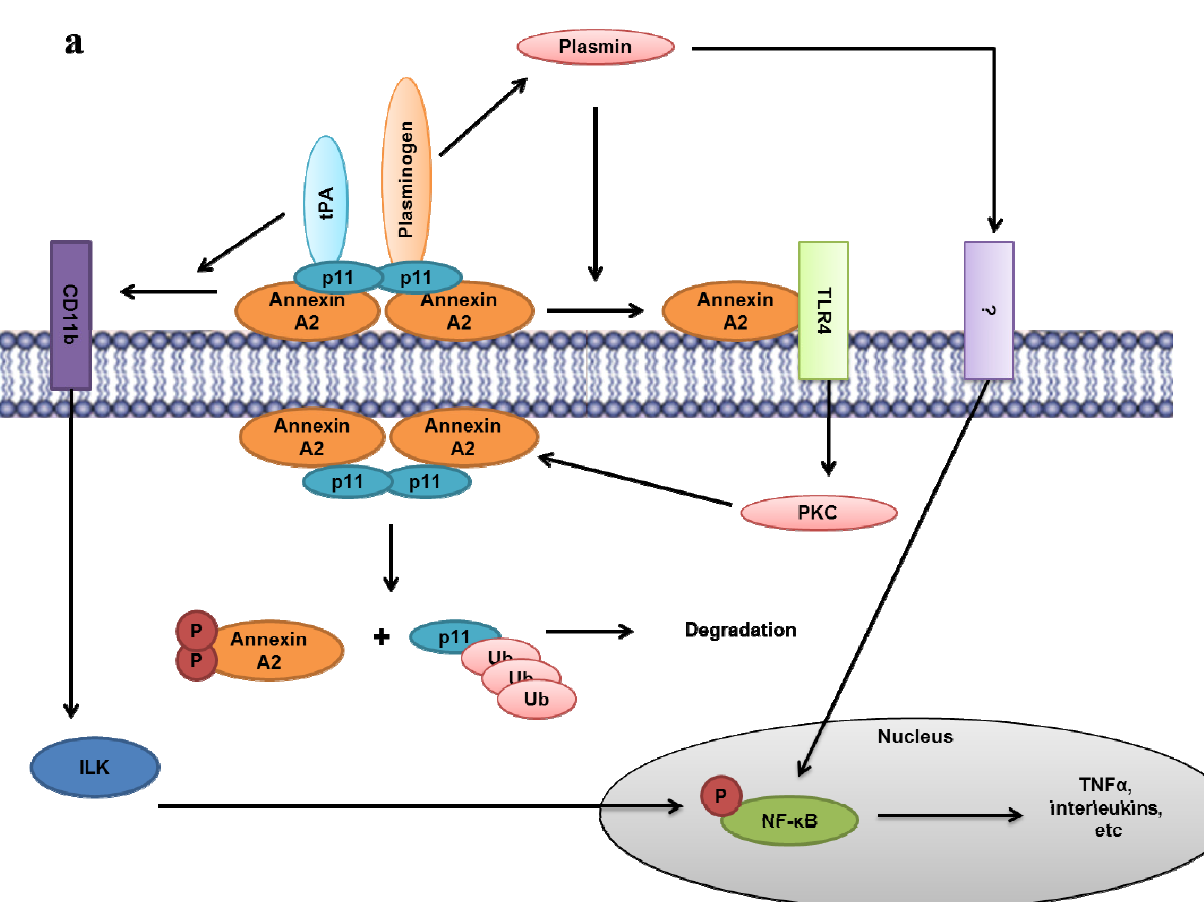
Figure 4. Experimental model of inflammatory pathway regulation by the annexin A2-S100A10 heterotetramer. ( a ) Plasmin generated by the annexin A2-S100A10 heterotetramer (AIIt) induces the co-localization of membrane-bound annexin A2 and Toll-Like receptor 4 (TLR4), which causes PKC-mediated phosphorylation of cytoplasmic annexin A2 at serines 11 and 25. The phosphorylation of annexin A2 disassembles AIIt allowing the ubiquitation and degradation of S100A10. In addition, tissue-plasminogen activator (tPA) binding to the carboxyl-terminal lysine residue of the S100A10 subunit induces activation of ILK in a CD11b-dependent manner. Both tPA-mediated ILK activation and plasmin (via an unidentified receptor) promote NF- κ B nuclear translocation where it induces production of proinflammatory mediators (TNF α , interleukins, etc .). ( b ) Progastrin binds to monomeric or dimeric annexin A2, but not AIIt, and induces clathrin-mediated endocytosis. Internalization of progastrin activates MAPKs, β -catenin, and nuclear translocation of NF- κ